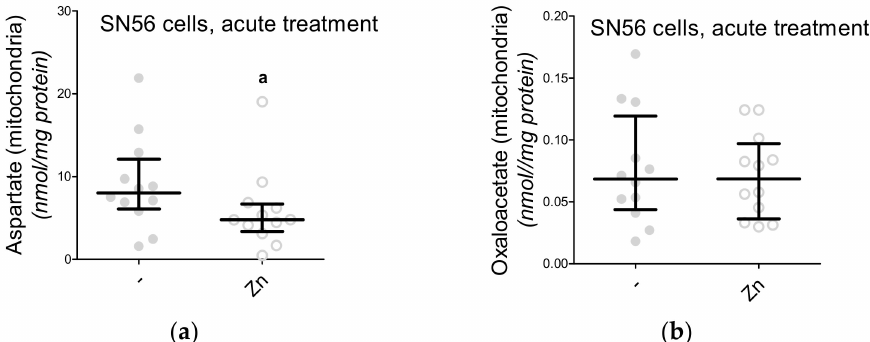
Figure 9. The impact of acute 0.15-mM Zn 2 + treatment on mitochondrial fractions isolated from SN56 cells: ( a ) mitochondrial aspartate level; ( b ) mitochondrial oxaloacetate level. Data are median (25th–75th percentile) from 12 experiments. Significantly di ff erent from SN56 control ( a — p < 0.05). Abbreviations: Zn—zinc ions.